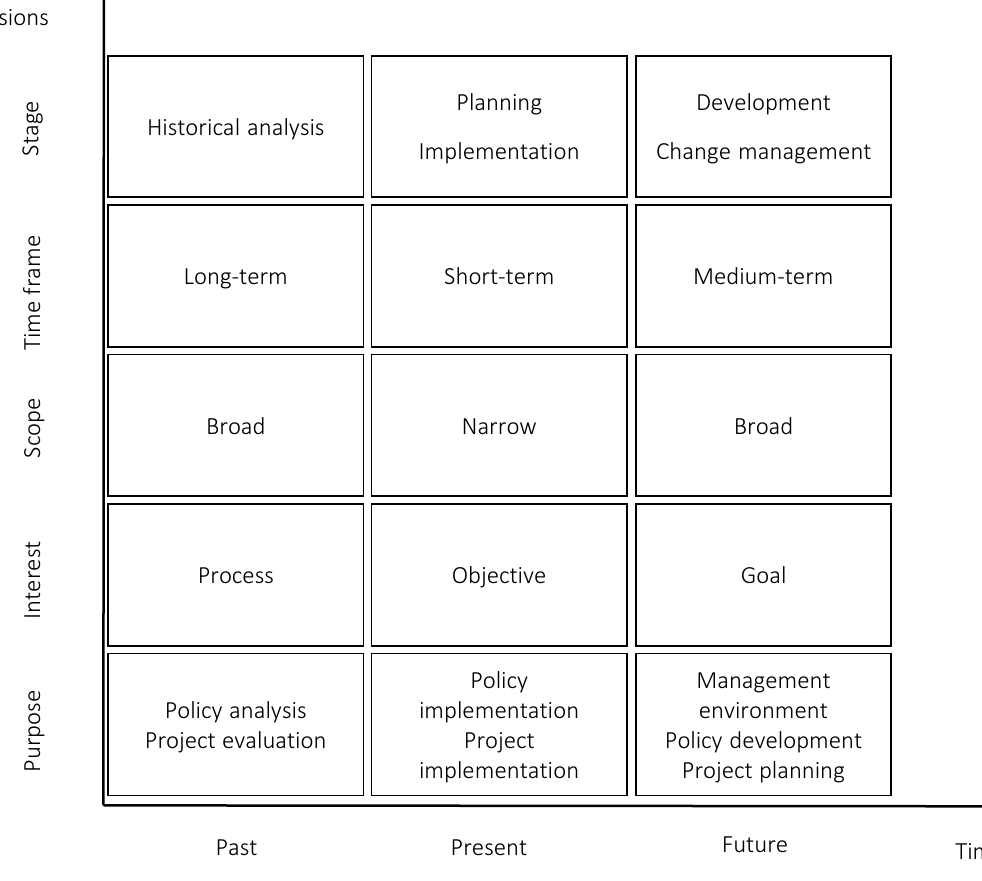
Figure 1. Time focus of a stakeholder analysis by key